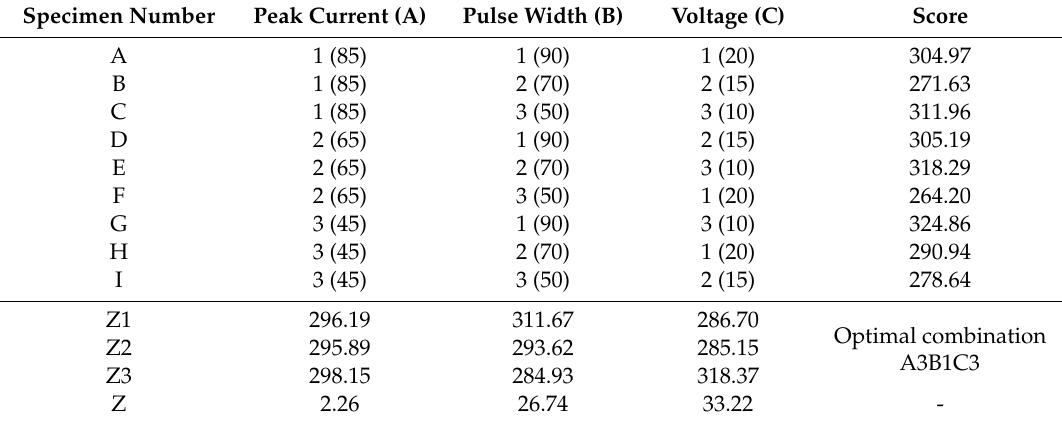
Table 9. Comprehensive score orthogonal experiment analysis